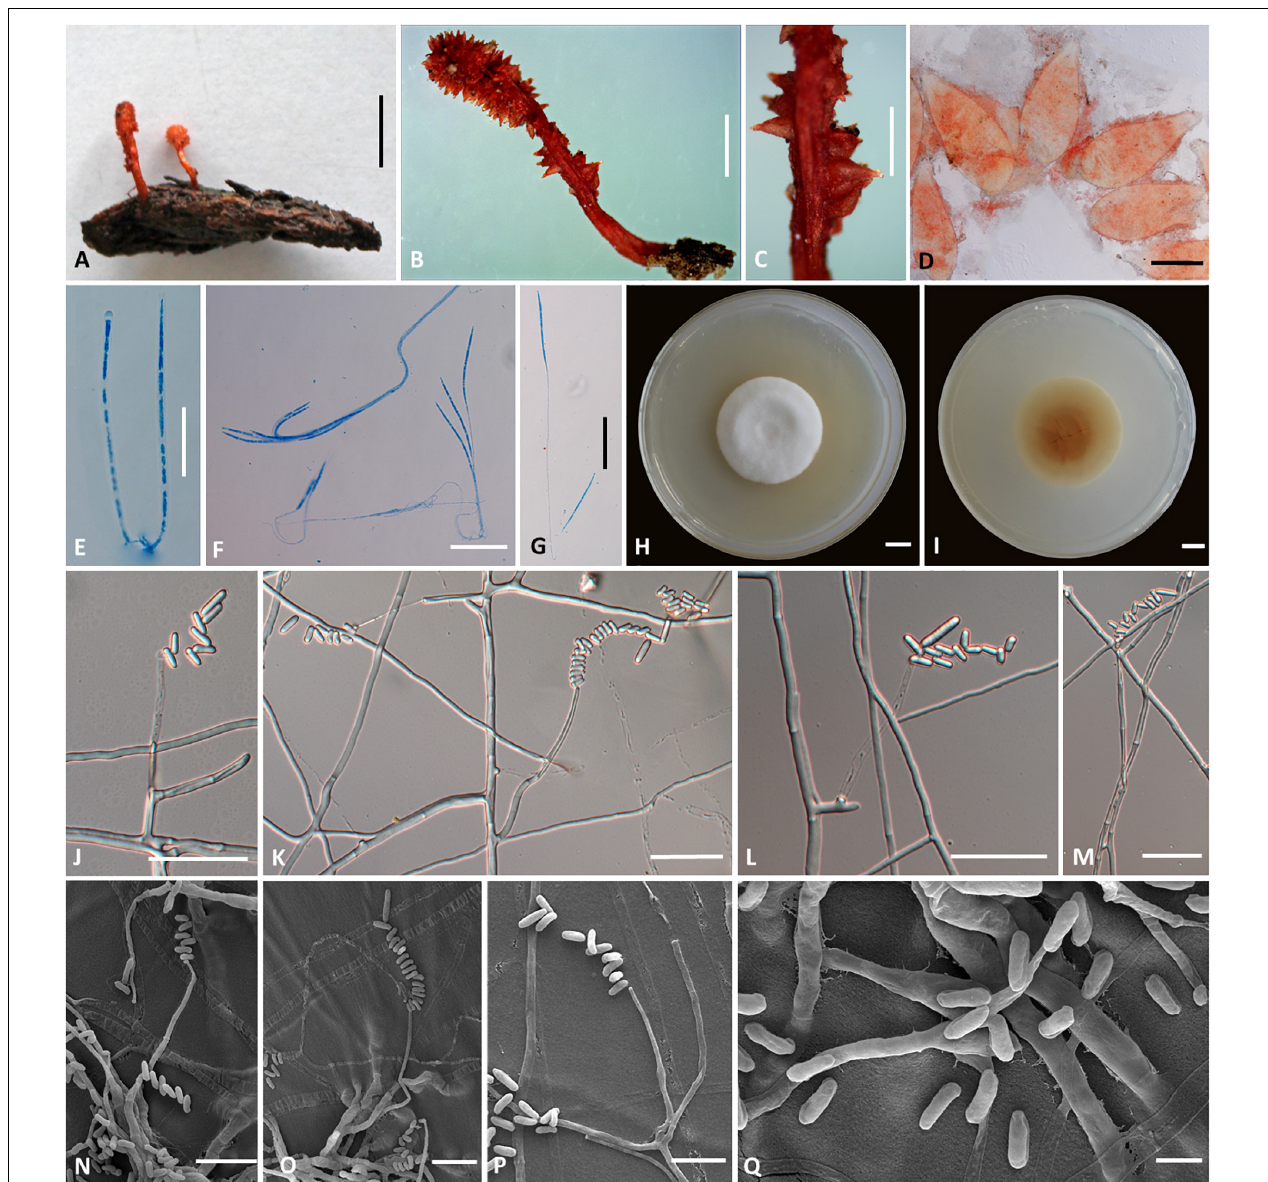
FIGURE 3 | Cordyceps longiphialis . (A,B) Fungus on the host of Lepidoptera. (C) Fertile part. (D) Perithecia. (E) Asci. (F,G) Ascospore. (H,I) Colony obverse (H) and reverse (I) on PDA at 14 days. (J–P) Phialide. (Q) Conidia. Scale bars: (A) = 5 mm; (B) = 2 mm; (C) = 1 mm; (D) = 200 µ m; (E–G,J–M) = 20 µ m; (H,I) = 10 mm; (N–P) = 10 µ m; (Q) = 5 µ